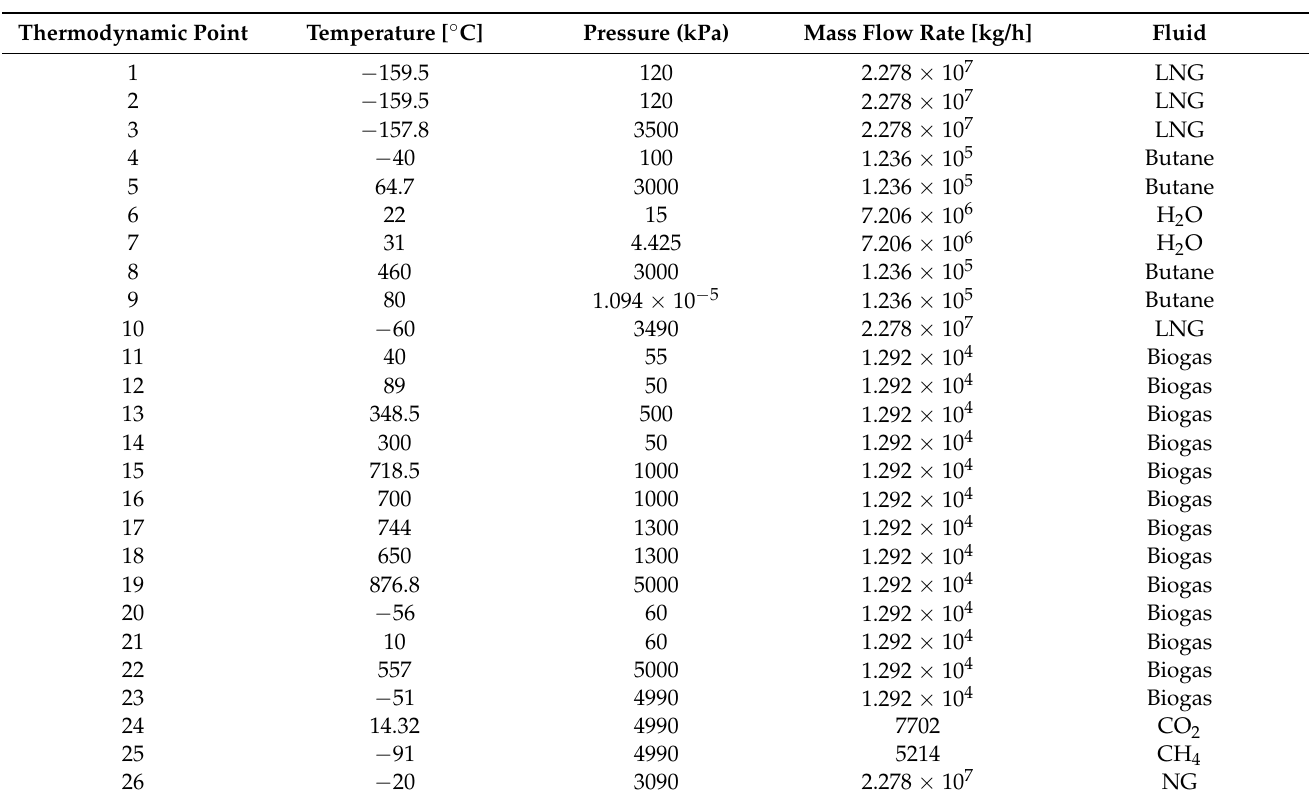
Table 6. Detail of Configuration III operating values using butane as the working